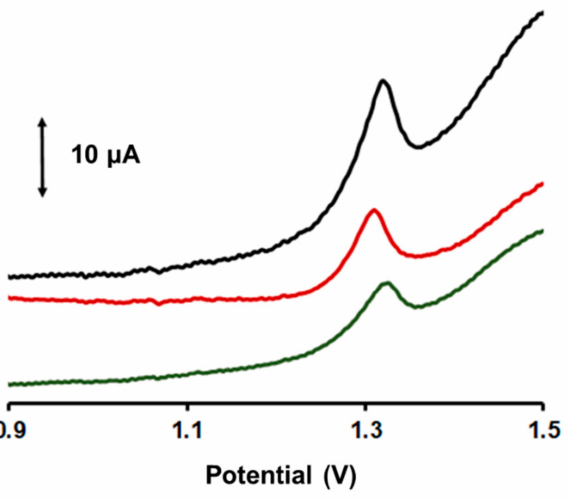
Figure 5. Background-subtracted DP voltammograms for GLU concentrations in the range of 100–300 µ M in phosphate buffer 0.1 M, pH 6 obtained with the modified